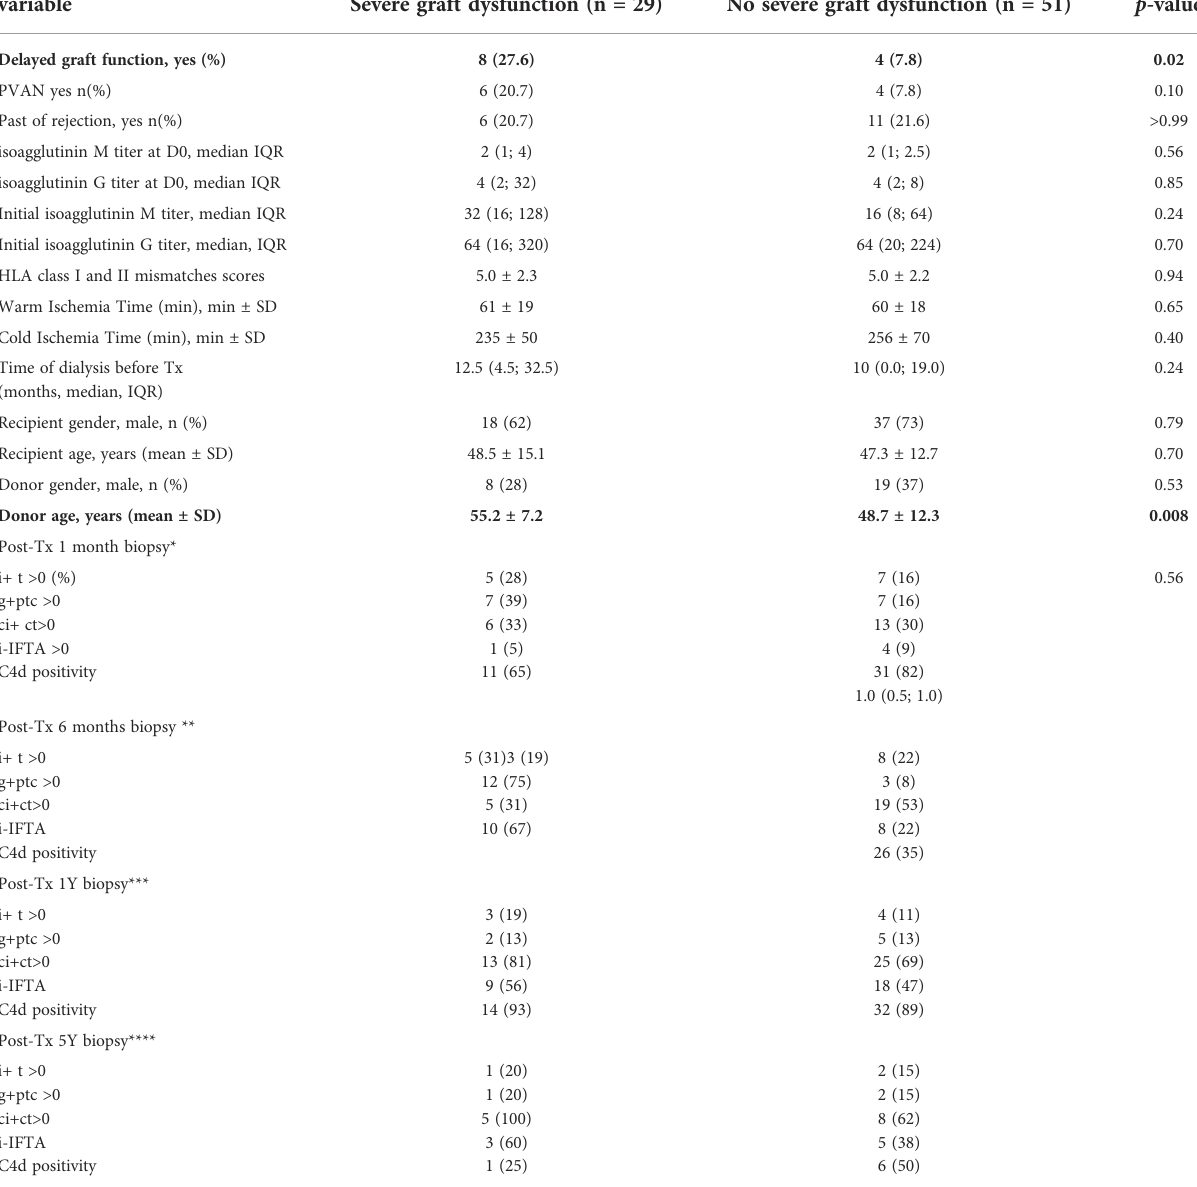
TABLE 3 Comparison of ABOi recipients without DSA according to the development of severe graft dysfunction (de fi ned by a CKD-Epi eGFR<30 mL/min/1.73m²) at last follow-up. variable Severe graft dysfunction (n = 29) No severe graft dysfunction (n = 51) p